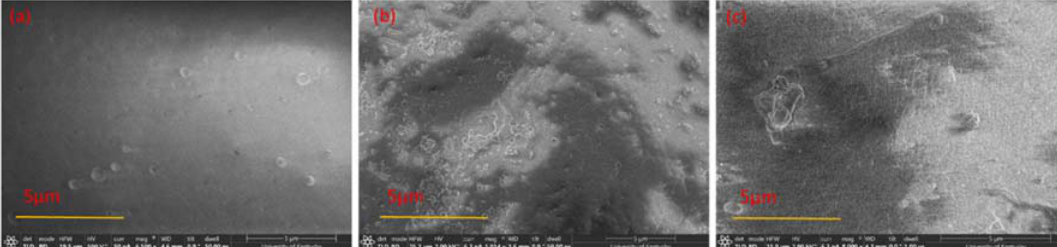
Figure 9. FIB-SEM images of PSf/PolarClean membranes surface: ( a ) Original; ( b ) After BSA filtration; ( c ) After DI water backwash.